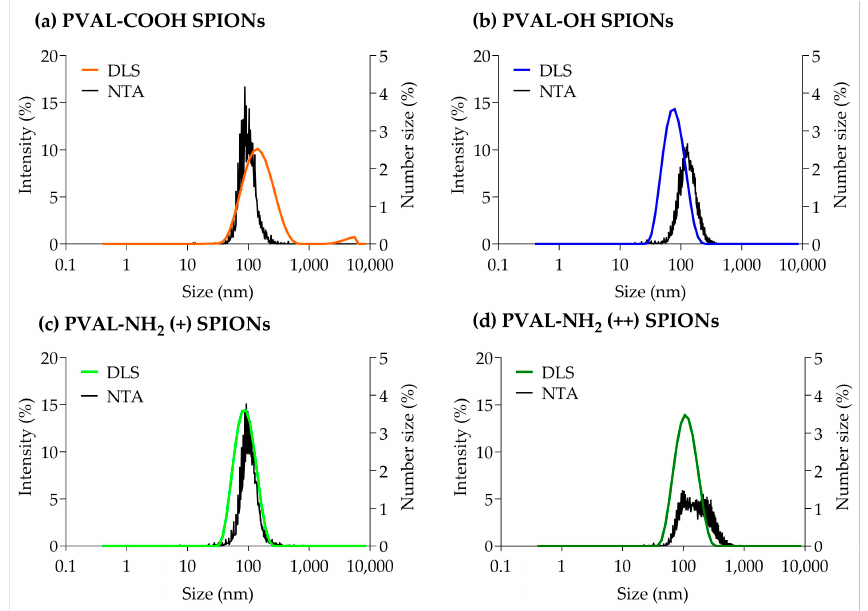
Figure 1. Graphs obtained from DLS and NTA particle size measurements for ( a ) PVAL-COOH SPIONs, ( b ) PVAL-OH SPIONs, ( c ) PVAL-NH 2 SPIONs (+) and ( d ) PVAL-NH 2 SPIONs (++). DLS size distribution was plotted as a percentage of the total intensity (left axis). NTA size distribution was plotted as a percentage of the total number of measured NPs (right axis). Table 1. Particle sizes obtained by DLS and NTA. All values are averaged from 3 different